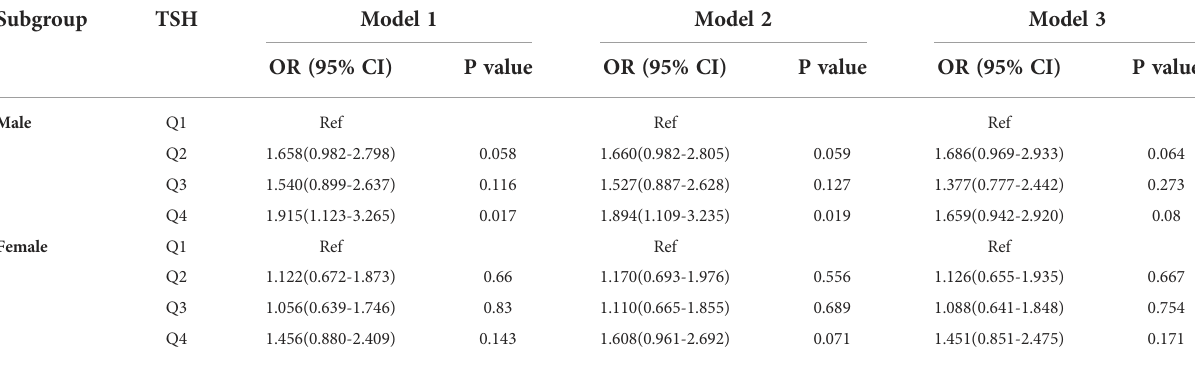
TABLE 3 Association of thyroid stimulating hormone level with Helicobacter pylori seropositivity based on subgroup of sex. Subgroup TSH